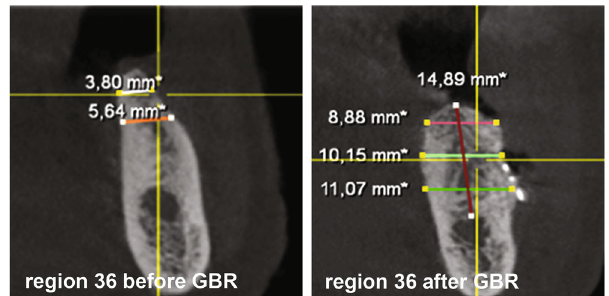
Figure 23: DVT — sections; implant position region 36 before and after GBR.